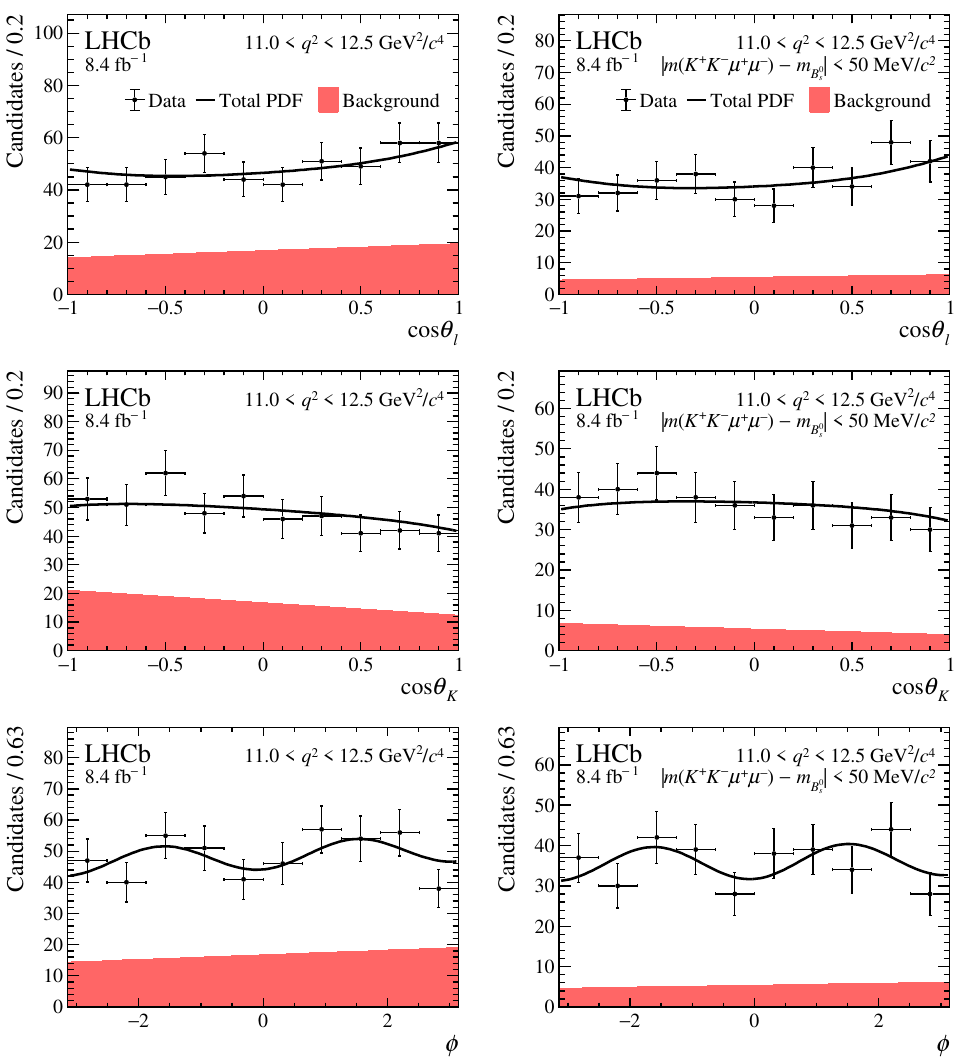
Figure 9 . Projections in the region 11 . 0 < q 2 < 12 . 5 GeV 2 /c 4 for the angular distributions of the combined 2011–2012, 2016 and 2017–2018 data sets. The data are overlaid with the projection of the combined PDF. The red shaded area indicates the background component and the solid black line the total PDF. The angular projections are given for candidates in (left) the entire mass region used to determine the observables in this paper and (right) the signal mass window ± 50 MeV/ c 2 around the known B 0 s